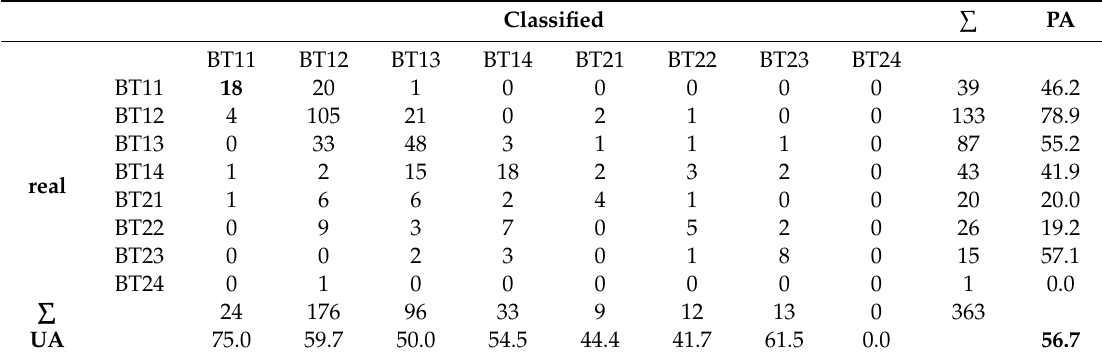
Table 4. Error matrix of building types after the random forest classification.